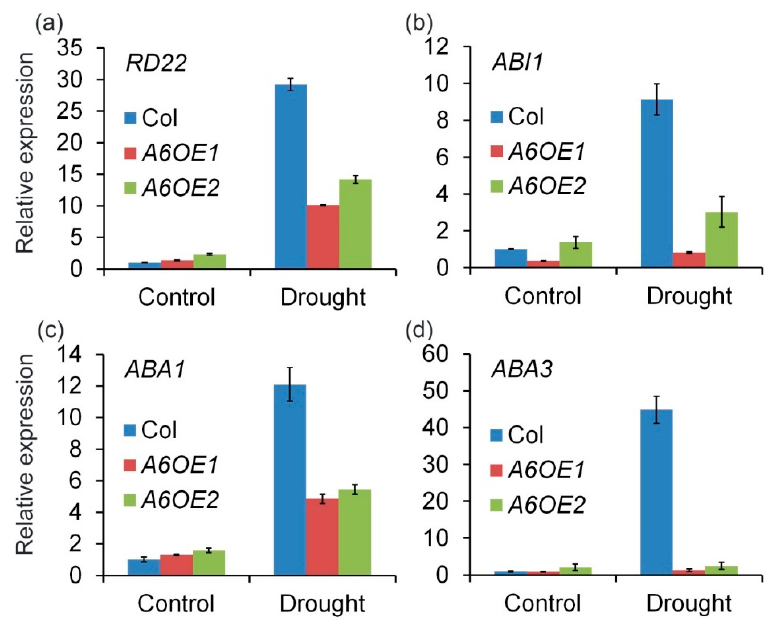
Figure 5. ZmPP2C-A6 altered expression of stress-responsive genes in transgenic Arabidopsis . ( a ) The RD22 were involved in responding to drought and ABA treatment; ( b ) The ABI1 is the ABA signaling regulators gene which was also had a great effect on the ABA biosynthesis in the plants; ( c , d ) The ABA1 and ABA3 genes are the main function of ABA biosynthesis. Expression of stress-responsive genes in ZmPP2C-A6 transgenic plants and Col. Overexpression of ZmPP2C-A6 reduced the expression of drought responsible marker genes. The expression of all marker genes under normal and drought conditions was examined by qRT-PCR. Three-week-old plants were either watered or drought-stressed for 8 days. Int. J. Mol. Sci. 2019 , 20 , x FOR PEER REVIEW